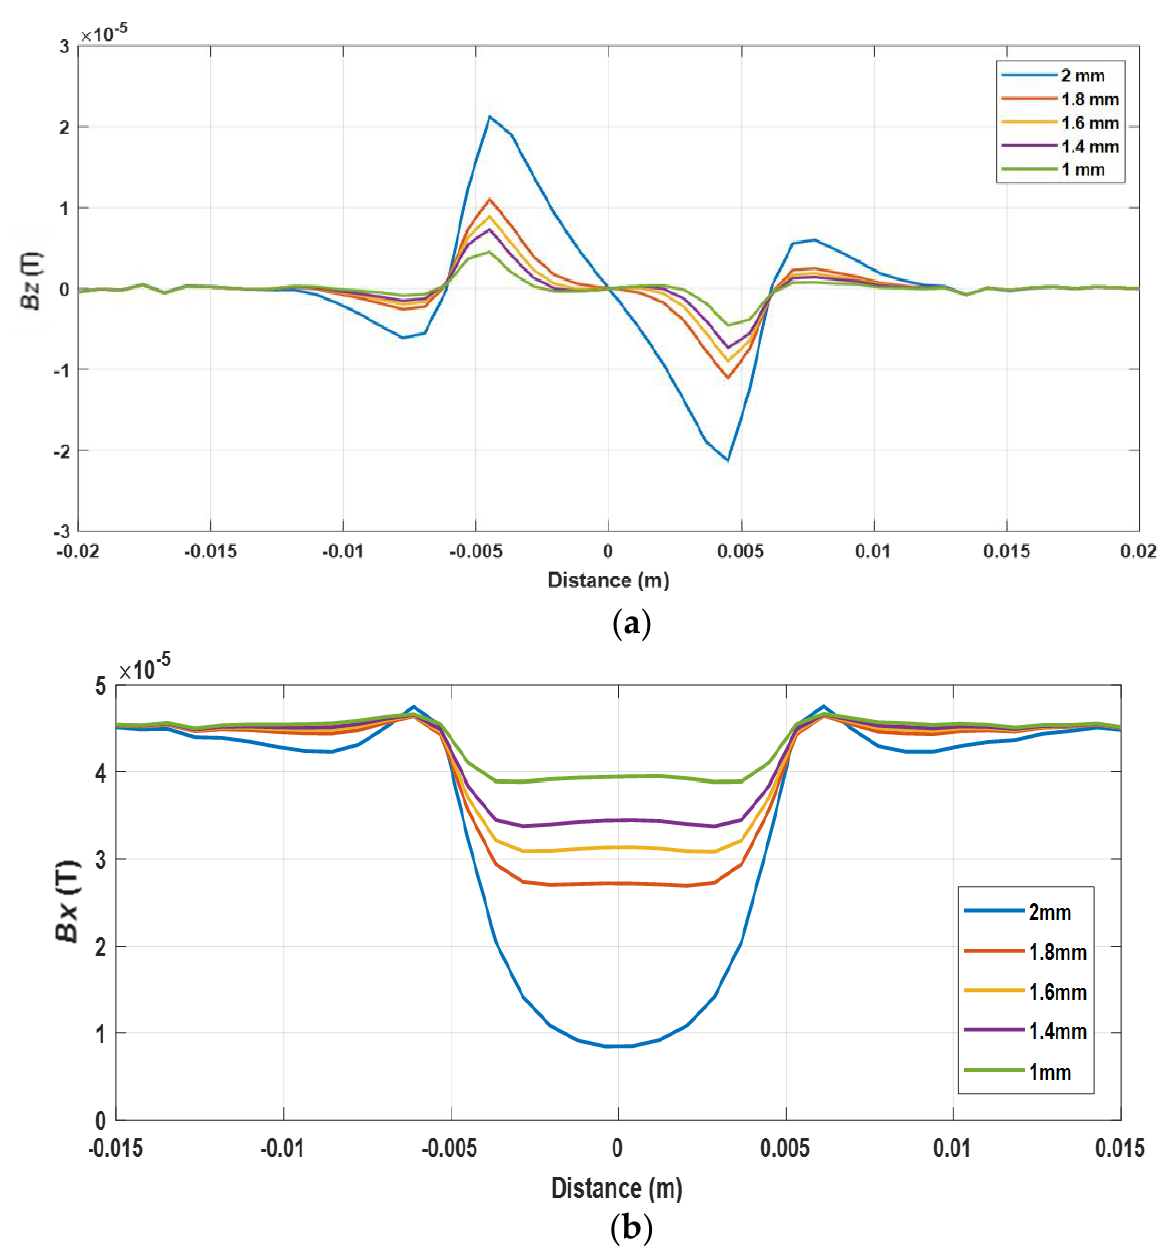
Figure 4. The magnetic 𝑩 field signal received by the sensing probe under different depths of the cracks ( a ) 𝑩 , ( b ) 𝑩 . 𝑧 𝑥